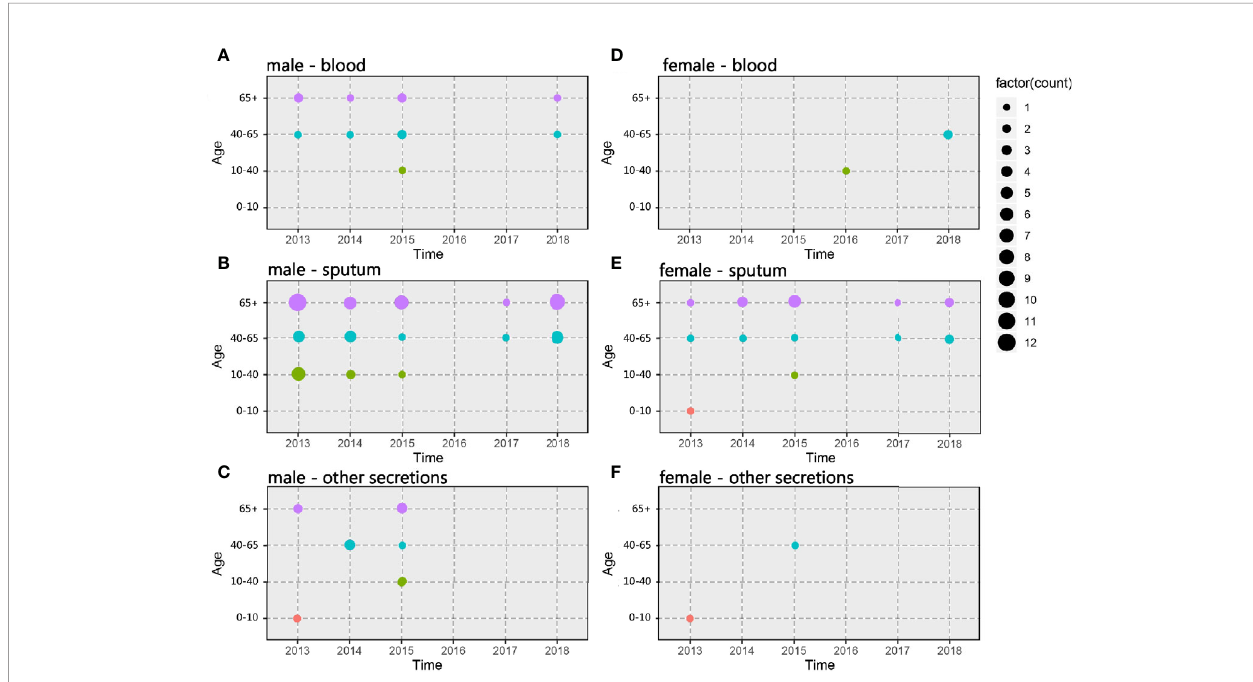
FIGURE 1 | Spatiotemporal, demographic, and clinical characteristics of 105 isolates of Shunde hospital. (A – C) Sample distribution from male patients; (D – F) Sample distribution from female patients; the sampling time range was 2013 – 2018, and the patients were divided into four groups according to age: 0 – 10 years old, 10 – 40 years old, 40 – 65 years old and over 65 years old. The sampling source was divided into three groups: blood, sputum, and other secretions.